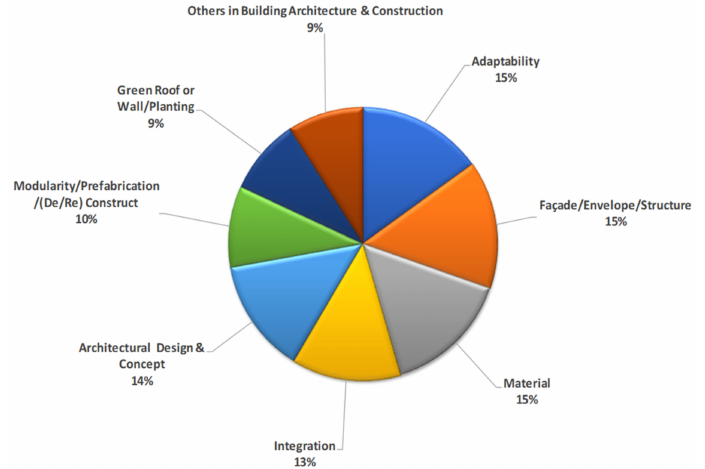
Figure 7. Architecture and construction innovations within the top five houses of SD